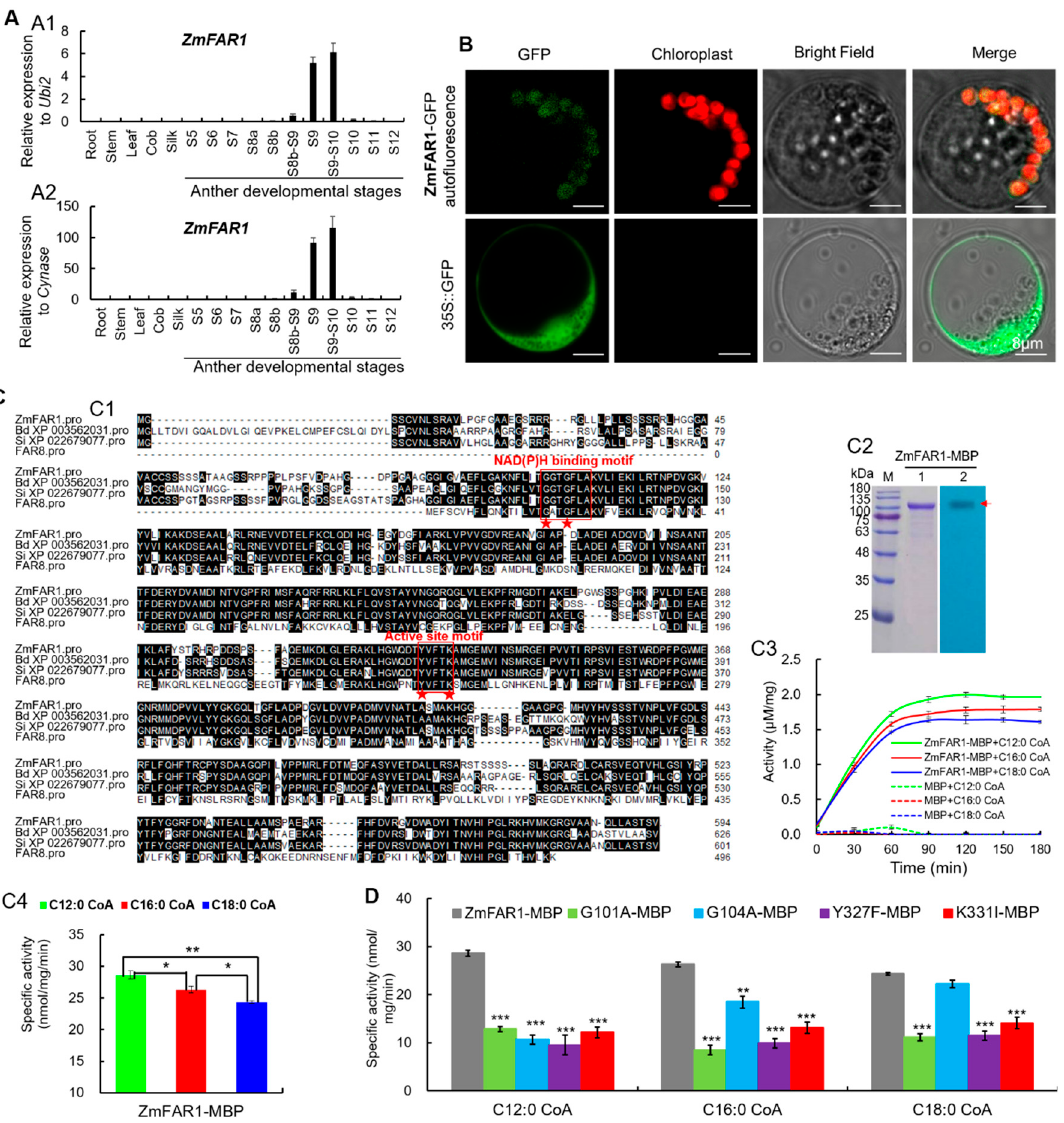
Figure 5. Spatiotemporal expression analysis of ZmFAR1 and subcellular localization and enzyme activity analysis of ZmFAR1 protein: ( A ) spatiotemporal expression analysis of ZmFAR1 by qRT-PCR assay with ZmUbi2 ( A1 ) and ZmCynase ( A2 ) as the internal controls, respectively. Error bars indicate SD. Each reaction was performed in three biological replicates with three technical repeats: ( B ) confocal images showing the subcellular localization of ZmFAR1 in maize protoplasts. The constructs of ZmFAR1-GFP and 35S-GFP were expressed in maize protoplasts. The chlorophyll autofluorescence was used as a plastid marker. The 35S-GFP vector was used as a negative control; ( C ) ZmFAR1 possessed catalytic activities to three fatty acyl–CoA substrates in vitro: ( C1 ) alignment of ZmFAR1 and its putative orthologs in plants based on the CLUSTALW program. The conserved NAD(P)H binding Rossmann-fold domain (GGTGFLA) and active site motif (YVFTK) in the FAR family were highlighted with the red rectangular borders. The red pentagrams indicated the key